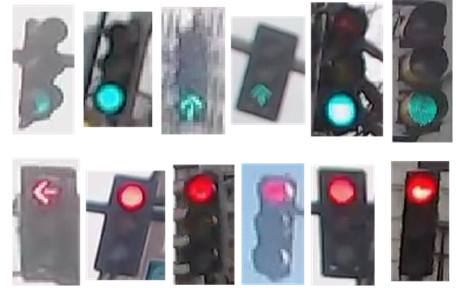
Figure 7. Schematic diagram of the object detection function and the traffic light detection func- tion.